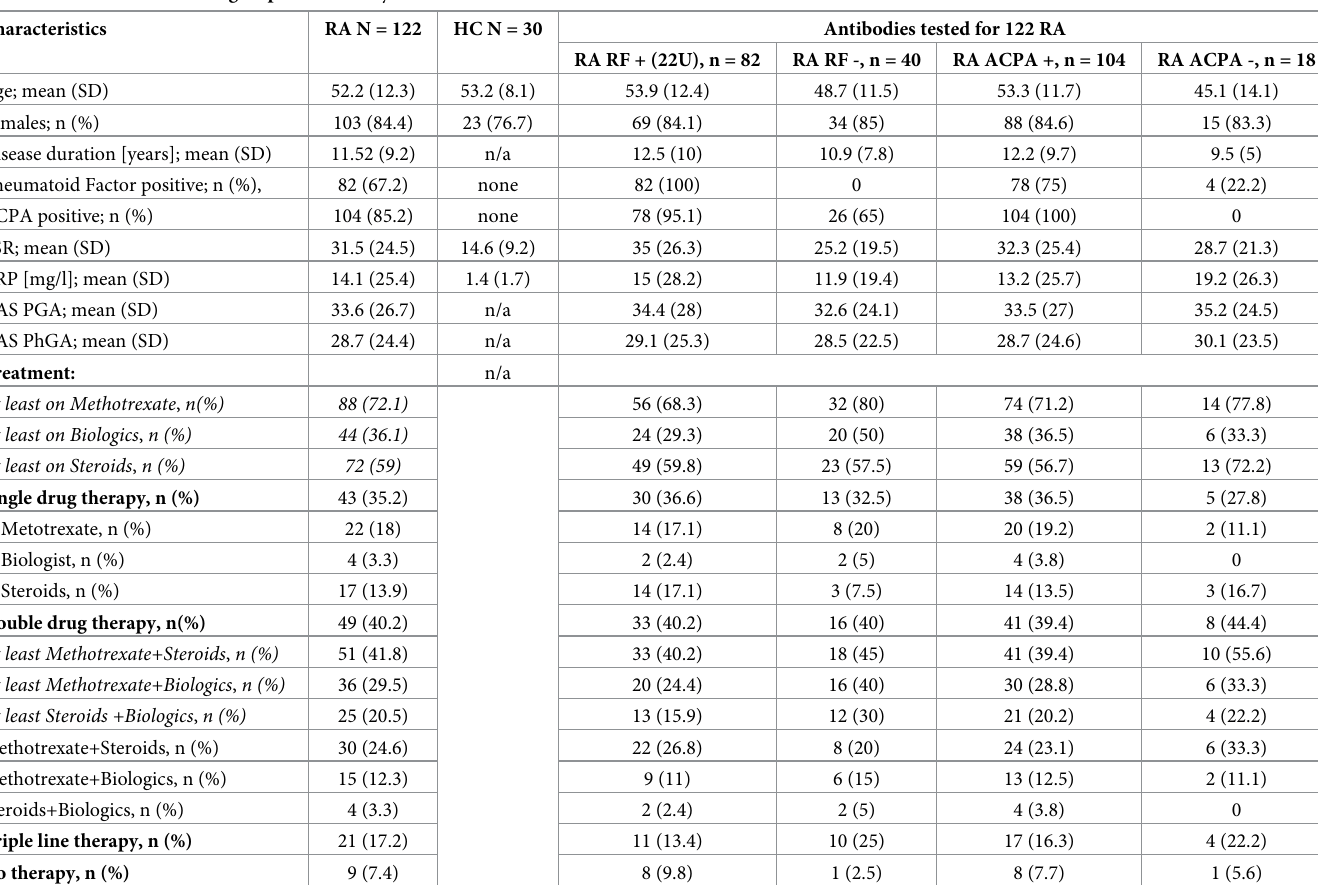
Table 1. Characteristic of the groups. HC healthy